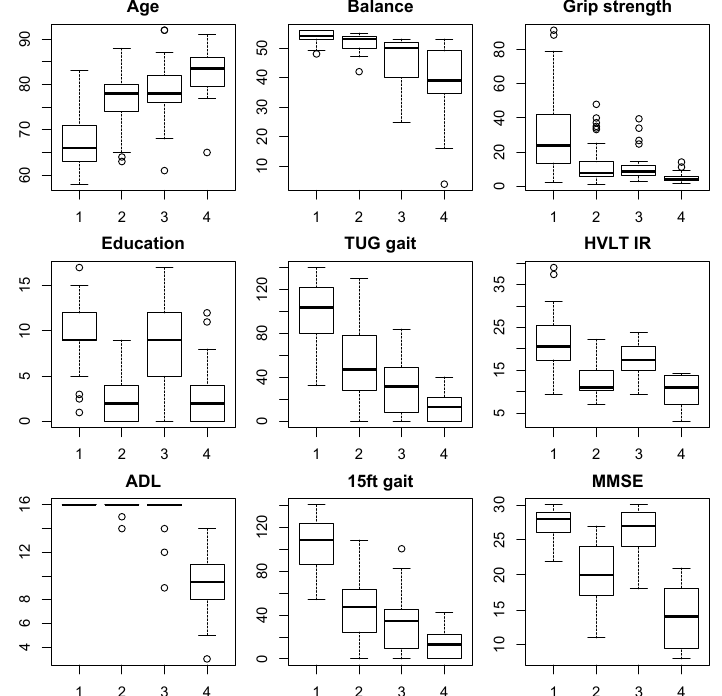
Figure 3. Box plots of the scores on the variables entered into the cluster analysis, split by cluster as indicated by the numbers on the x axis. HVLT DR scores are not included as the pattern is almost identical to the IR scores.